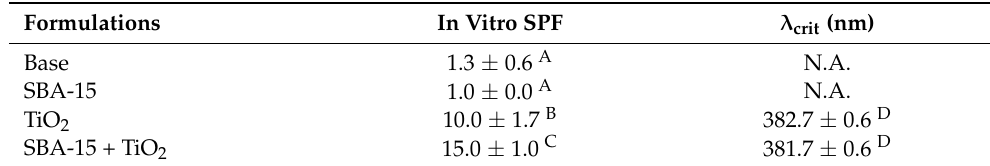
Table 3. Values of in vitro sun protection factor (SPF) and critical wavelength ( λ crit , nm) of the samples (lipstick base, SBA-15, TiO 2 , and SBA-15 + TiO 2 ).